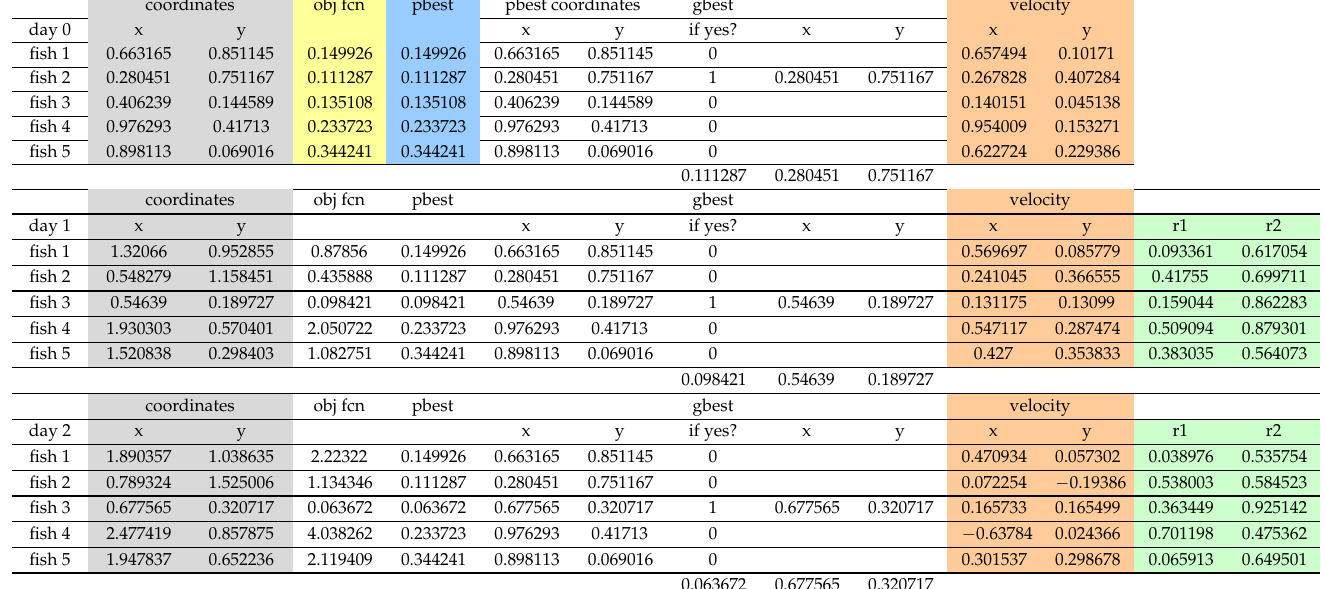
Table A1. A Demonstration of PSO (five particles, two